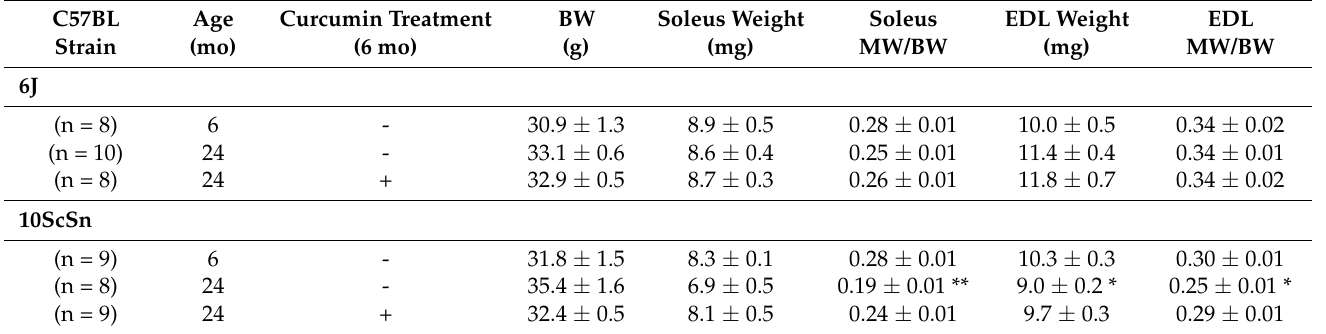
Table 1. Body and hindlimb muscle weights of adult and old mice from two C57BL strains.